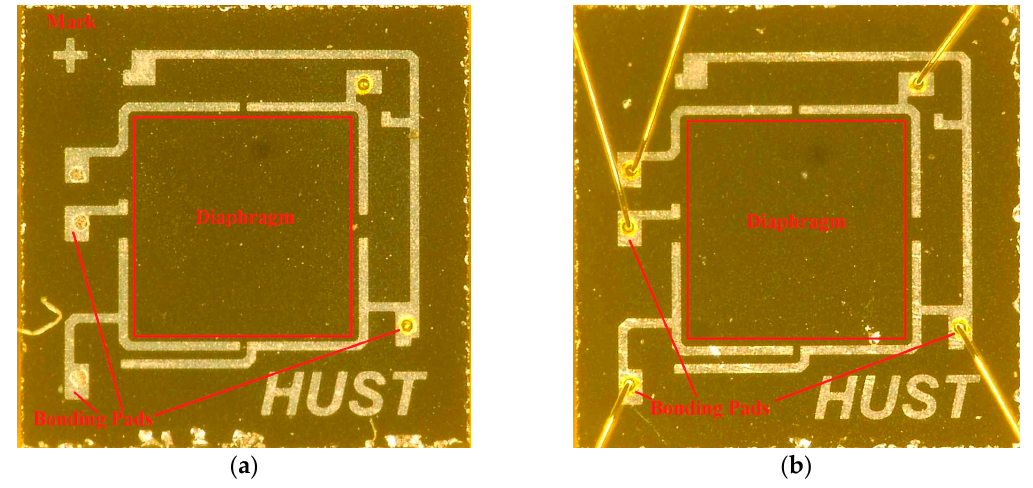
Figure 3. ( a ) Pressure sensor with a shield layer. ( b ) Pressure sensor without a shield layer.